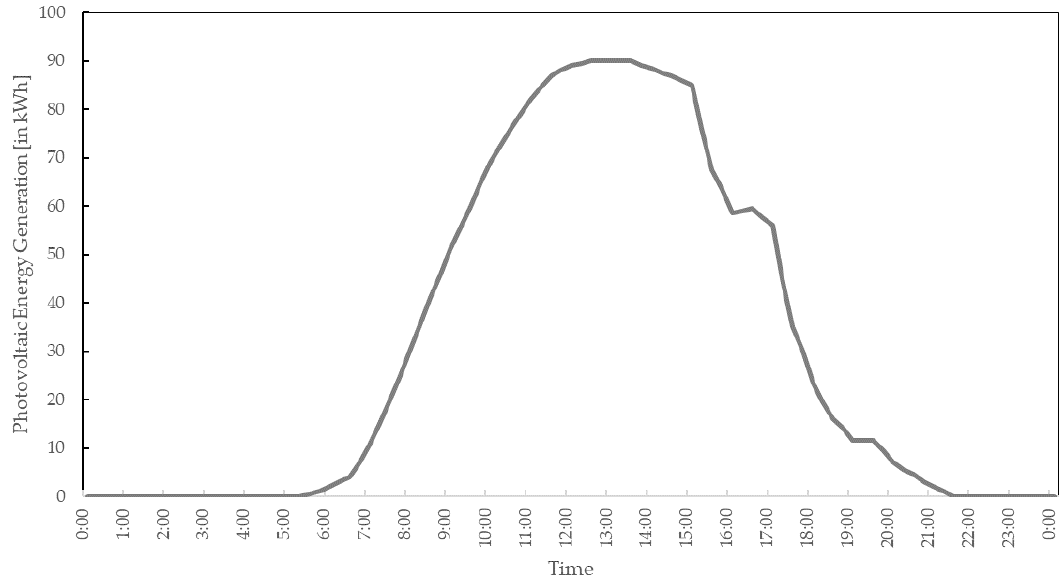
Figure 5. Photovoltaic Energy Generation Data.